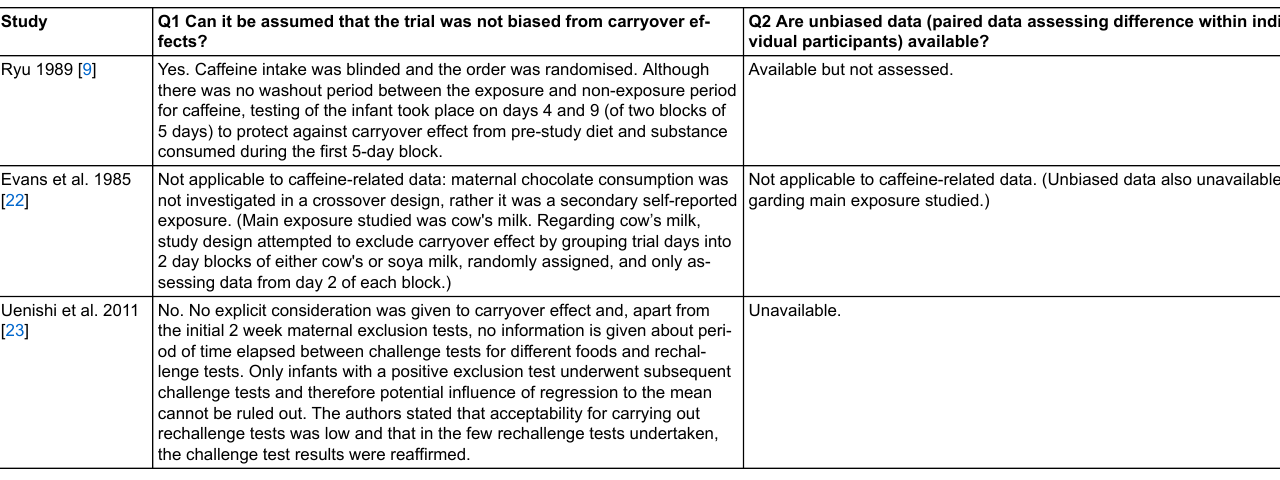
Table 2: Summary of crossover / N-of-1 trials additional risk of bias assessment.